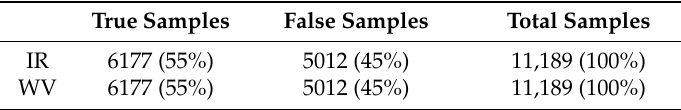
Table 1. Total number of true and false